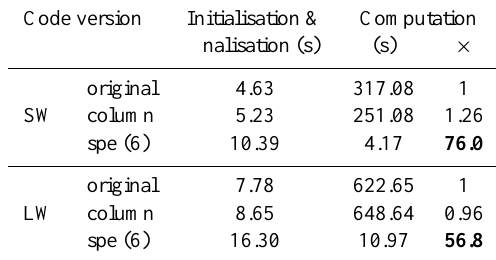
Table 3. Comparison of the computation time versus the time to initialise the column data structure and copy the results back (final- isation). The third column shows the computation’s speed improve-